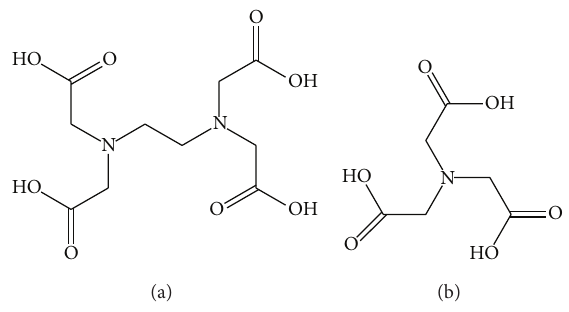
Figure 1: Structure of the EDTA (a) and NTA (b).